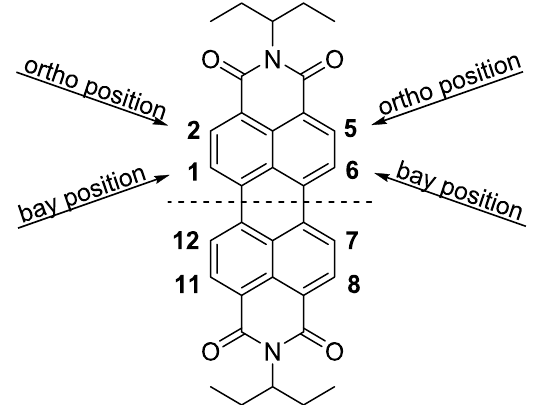
Figure 1. Molecular structure of the perylene diimide